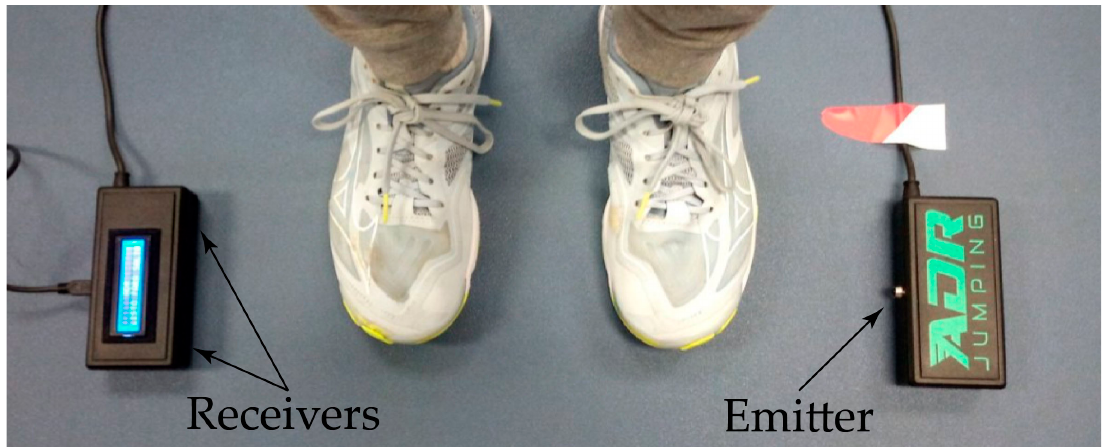
Figure 2. ADR jumping arrangement with the emitter facing the forefoot.